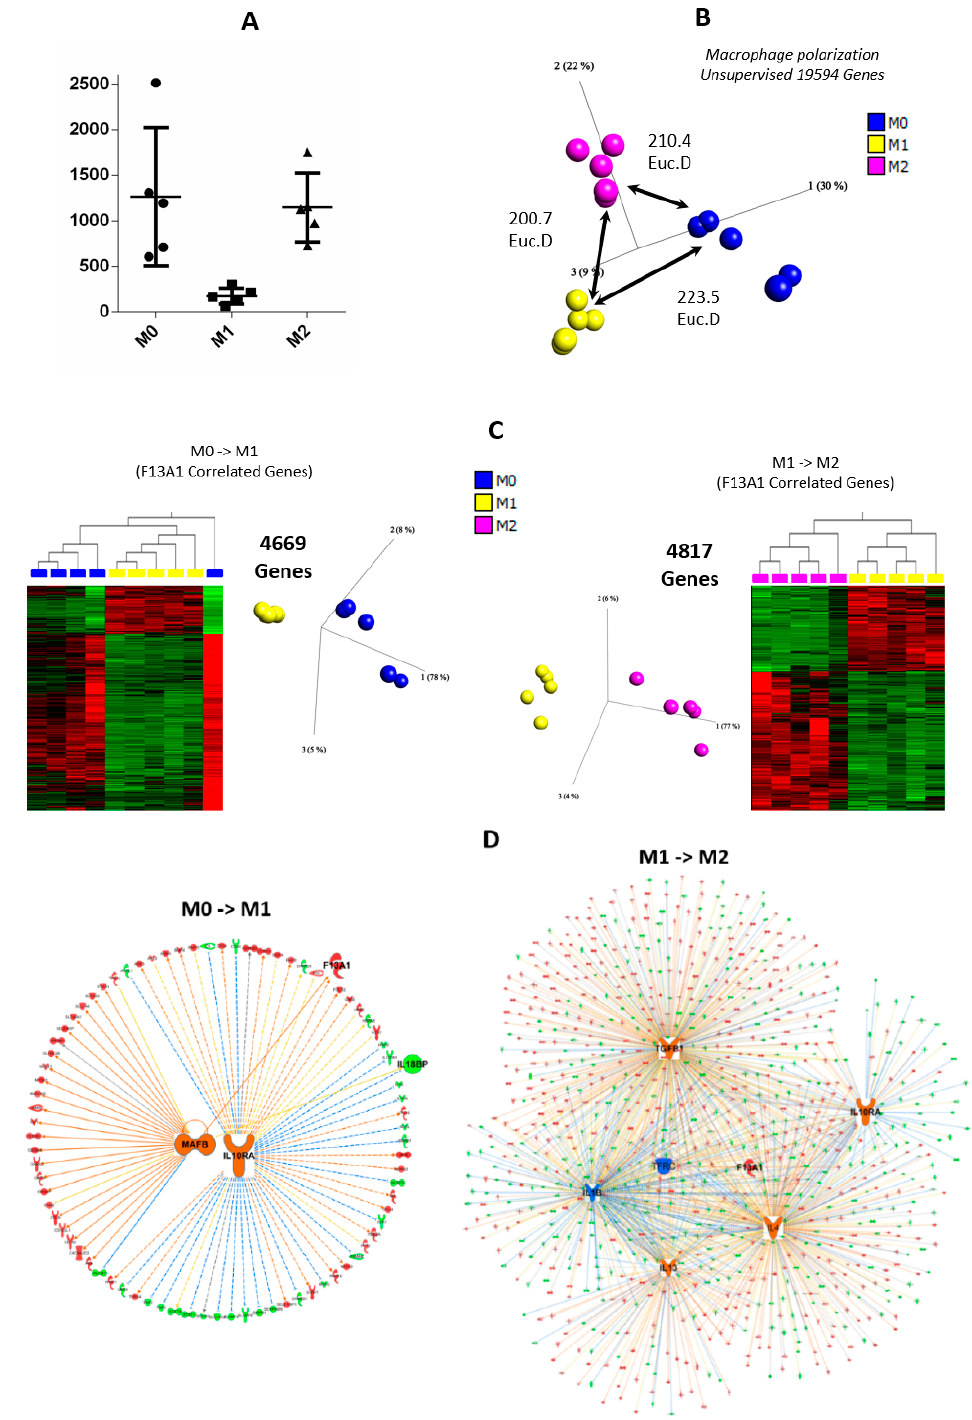
Figure 5. An expression analysis of macrophage polarization. ( A ) F13A1 expression in macrophage polarization. ( B ) The 3D-PCA of macrophage polarization with Euclidean distance (ED) between every macrophage polarization. Blue: M0; yellow: M1; and dark pink: M2. ( C ) A heatmap and 3D-PCA of significant F13A1-expression-correlated genes at p < 0.05; left: significantly correlated genes with F13A1 expression in M0 to M1; right: significantly correlated genes with F13A1 expression in M1 to M2. ( D ) Significant upstream regulators of F13A1-expression-correlated genes in left: M0 to M1; right: M1 to M2; orange: predicted overexpressed; blue: predicted under expressed; red: overexpressed; and green: under expressed in M0 compared to M1 or M1 compared to M2.